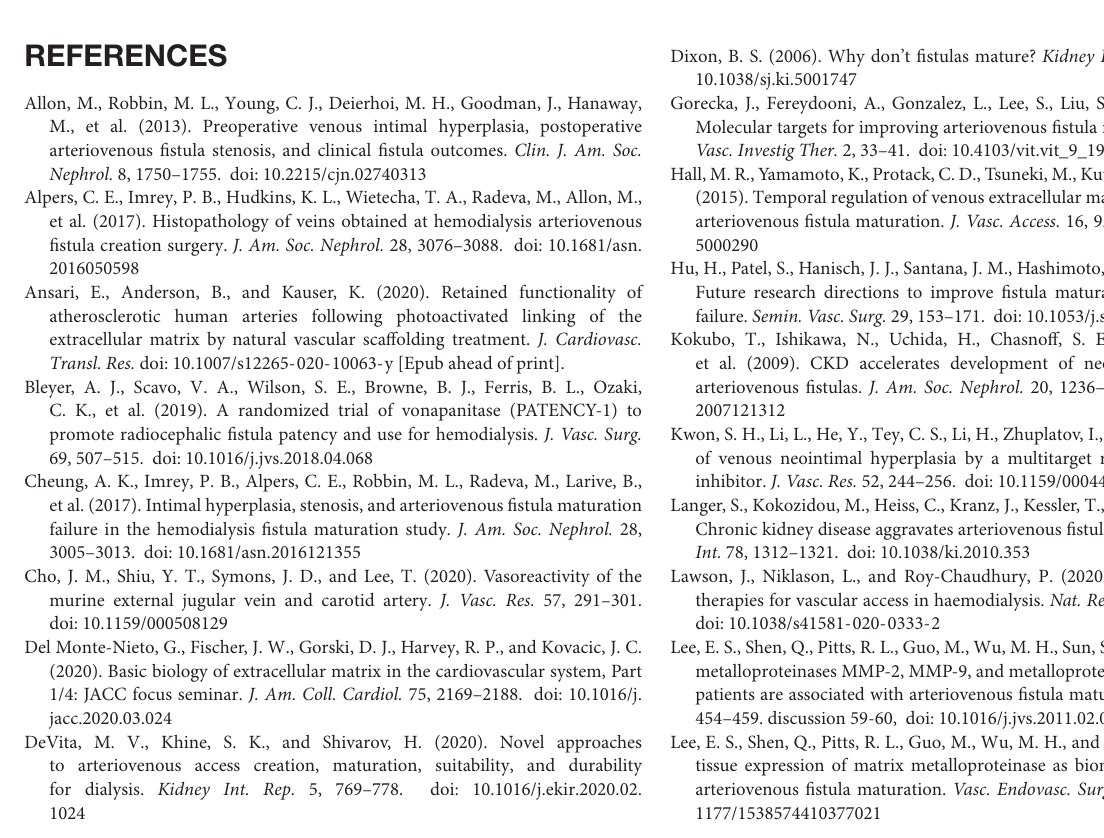
Supplementary Figure 1 | Analysis of no–surgery blood vessels. Representative VVG images of contralateral, no–surgery femoral artery and vein from animals treated with PBS (A) and NVS (B) . C and D show IEL–enclosed area of the no–surgery vein (C) and no–surgery artery (D) , and compare them to the IEL–enclosed area of the AVF venous limbs and arterial limbs, respectively. Results are presented as average ± standard error of mean. N = 8–9 in each of the no–surgery artery and vein groups. * p < 0.001. ** p < 0.005. A = Artery. V = Vein. L = Lumen. Supplementary Figure 2 | Whole AVF and arterial limbs. Morphometric analysis of the whole AVF (A–D) and arterial limb (E–H) of the AVF anastomosis. Results are presented as average ± standard deviation. N = 3–4 per group in week 1. N = 6–9 per group in week 4. Supplementary Figure 3 | Analysis of collagen fibers in AVF. Representative multiphoton autofluorescence (green) and SHG (red) images of AVFs at 4 weeks from animals treated with PBS (A,B) and NVS (C,D) . B and D show the enlarged regions of interest used for the analysis of fiber